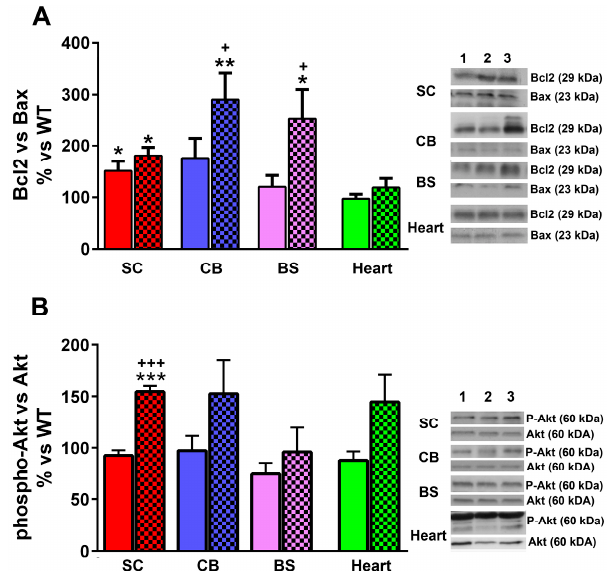
Figure 6. LGF treatment increases the expression of molecules involved in cellular survival in several structures of YG8R mice. ( A ) The effect of LGF on the ratio of Bcl2/Bax expression, analyzed through western blot in the spinal cord (SC, red bars), cerebellum (CB, blue bars), brain stem (BS, lilac bars), and heart ( green bars) of WT, YG8R ( uniform bars), and YG8R+LGF (bars with mesh ) mice. Note that LGF exerts an anti-apoptotic effect in the cerebellum and brain stem; ( B ) The effect of LGF on the ratio of P-Akt/Akt. Note that LGF treatment significantly increases the ratio in the spinal cord and heart. P-Akt, a mediator in the PI3K/Akt signaling pathway, is essential in the regulation of neuronal survival. Lane 1 (WT), Lane 2 (YG8R), Lane 3 (YG8R+LGF). Results are the mean ± SEM of three (in